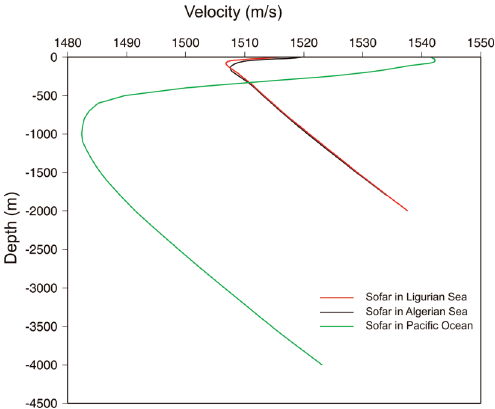
Fig. 5. Velocity of the SOFAR channel in May for the Mediterranean Sea. The SOFAR for the Pacific is reported for